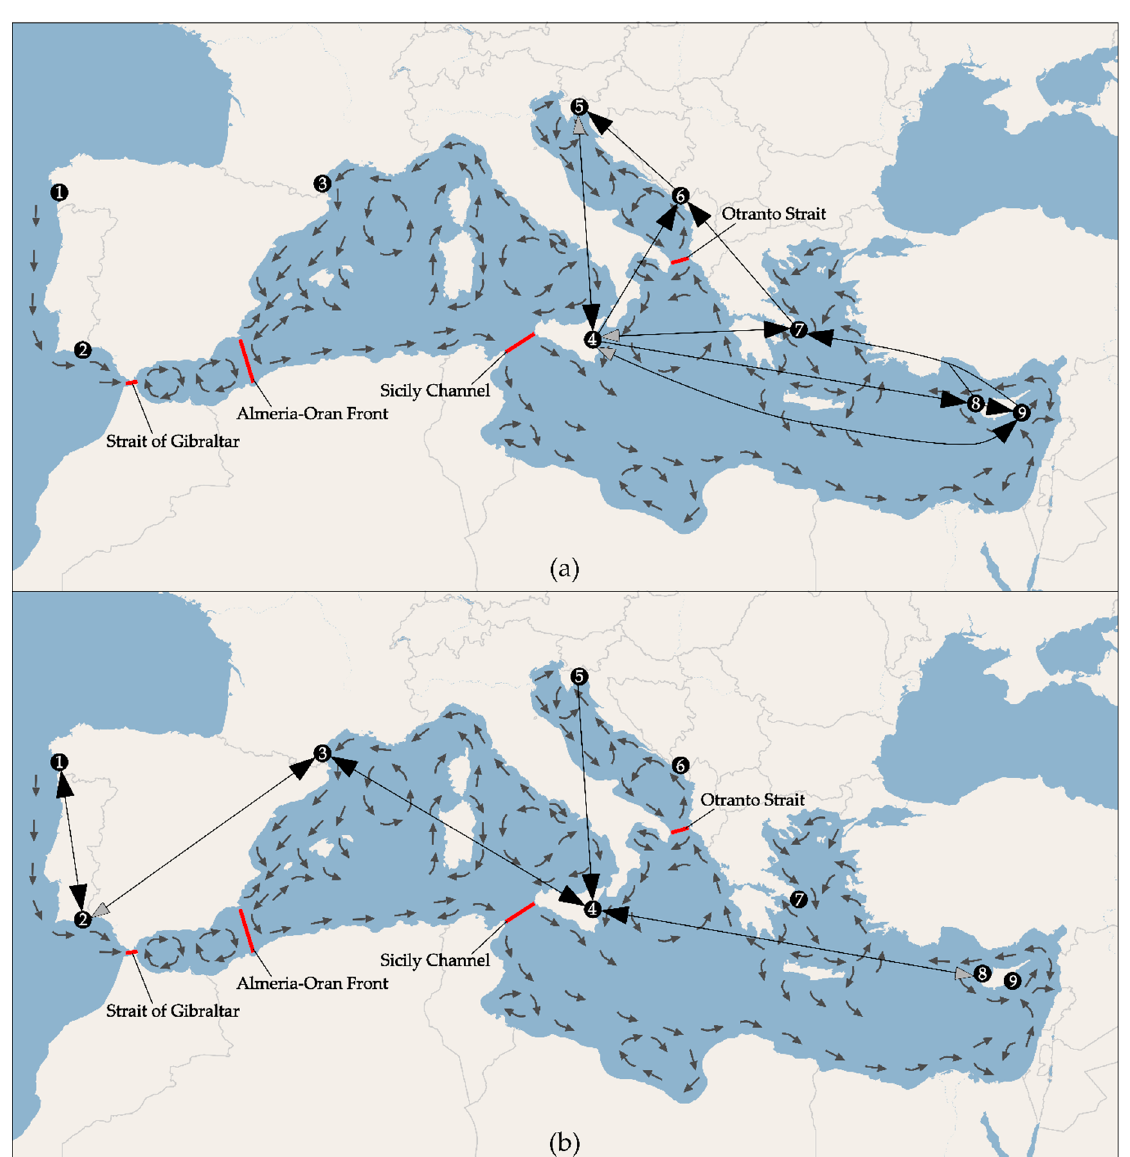
Figure 5. Migration routes of Gobius geniporus ( a ) and G. cruentatus ( b ) estimated by Migrate-n. Grey tips of arrows indicate less probable directions.